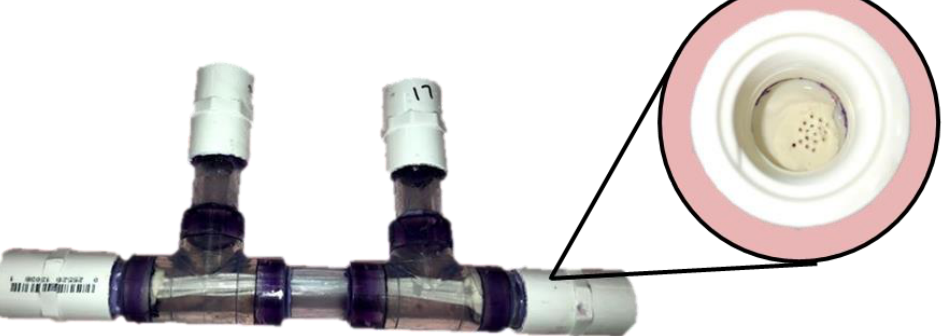
Figure 2. Example of the hemodialysis module used for running tests.